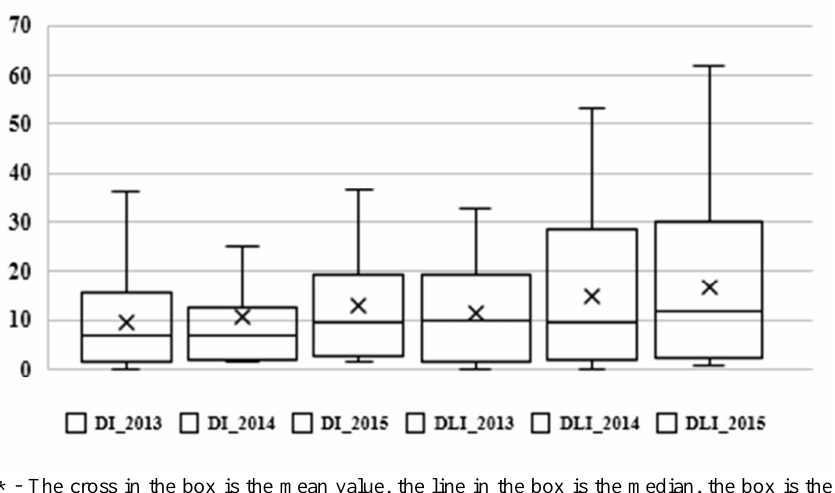
Figure 3. Share of new or significantly improved products in shipped products of the innovative sector, %